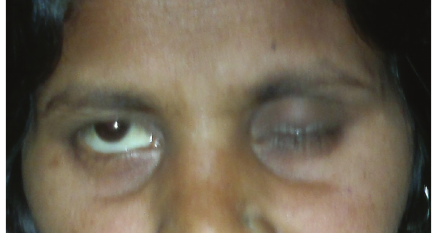
Figure 4: Bell’s phenomenon (upward rolling of eye